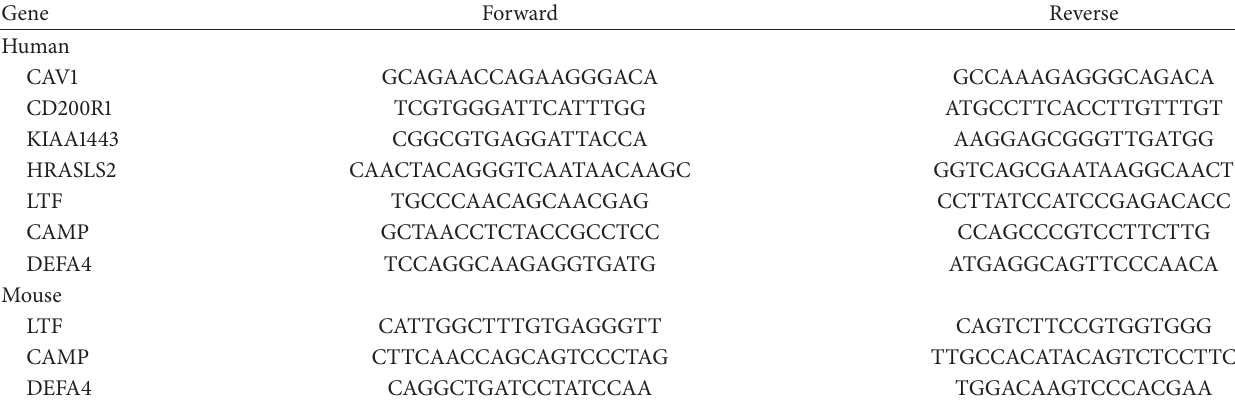
Table 1: Sequence of primers used for real-time quantitative PCR with SYBR